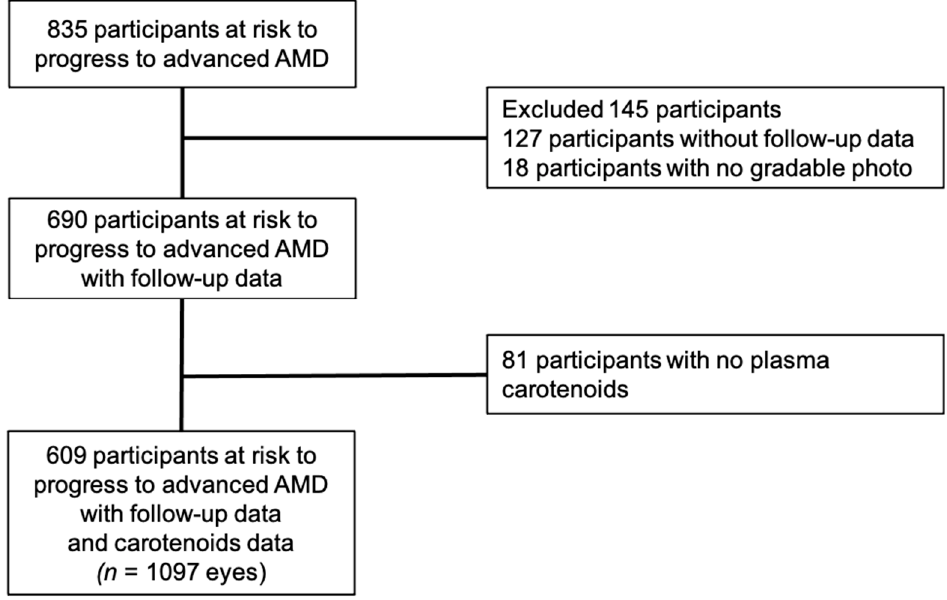
Figure 1. Flow chart showing selection of participants for analyses. AMD = age-related macular degeneration; Alienor = antioxydants, lipides essentiels, nutrition et maladies oculaires. Participants included in the analyses tended to be more frequent users of AMD nutritional supplements and were different regarding physical activity from participants excluded. They were not different regarding other sociodemographic, lifestyle, plasma measurements, medical, genetic, or ocular data (Table